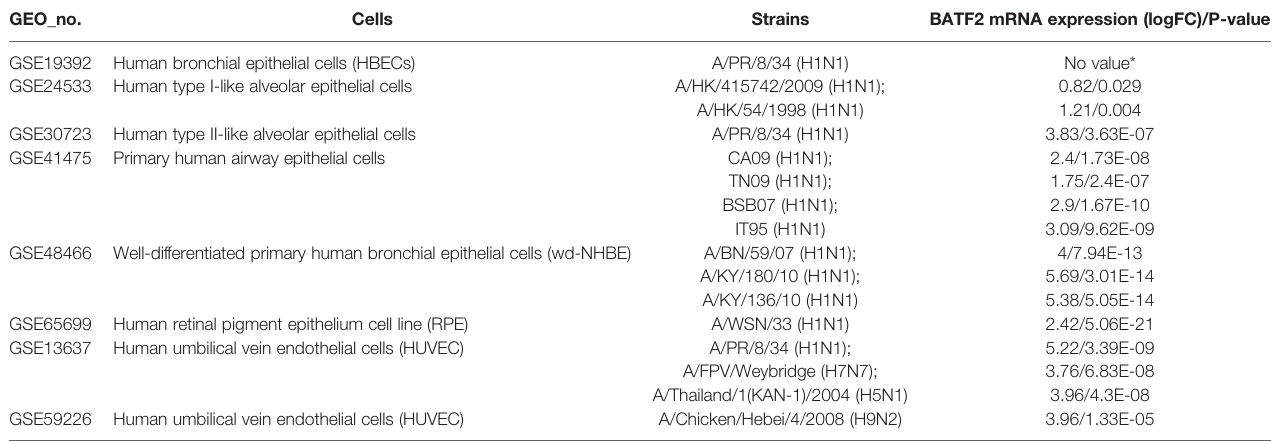
TABLE 4 | The mRNA expression of the BATF2 gene infected with in fl uenza virus.